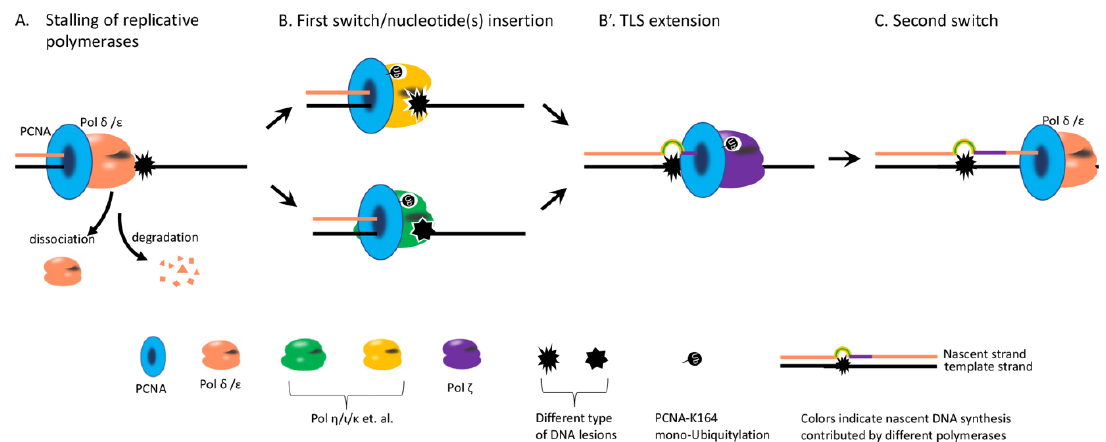
Figure 2. Illustration of the key steps during TLS. ( A ) DNA lesion causes stalling of a replicative DNA polymerase. It leads to dissociation or degradation of the polymerase. ( B ) A TLS polymerase capable of incorporating nucleotide(s) opposite to the DNA lesion is switched on at the blocked 3 ′ end. PCNA mono-Ub facilitates the recruitment of the “insertion” TLS polymerase. ( B’ ) In some cases, a second TLS polymerase (Pol ζ is very efficient at the extension) extends from the incorporated nucleotide(s) if the first TLS polymerase only performs the incorporation. ( C ) The TLS polymerase is switched back to a replicative polymerase.